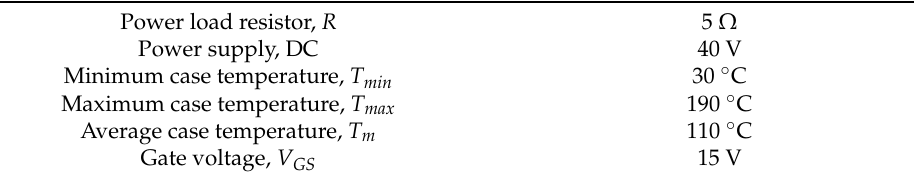
Figure 4. Temperature swing during the power cycling test. Table 2. The main parameters of experimental setup.